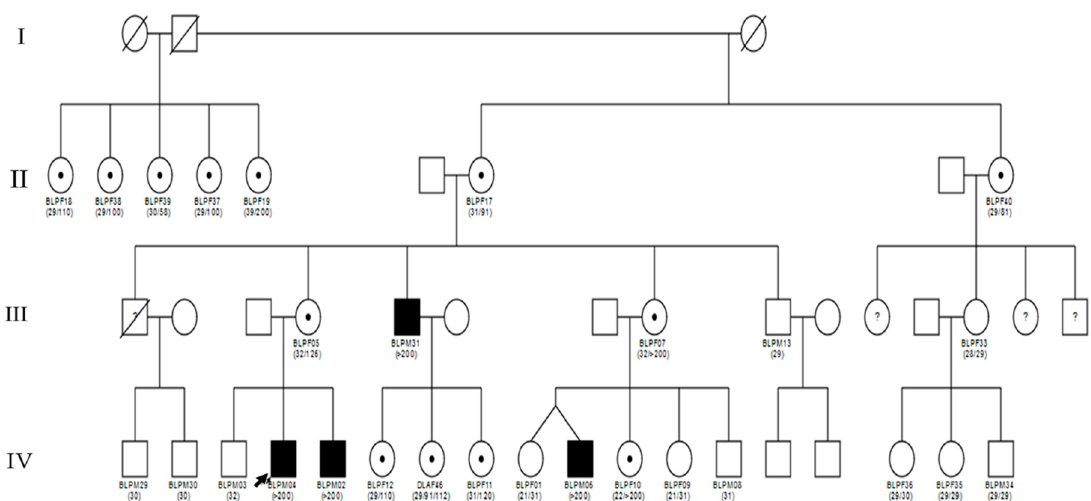
Figure 2. Description of our proband’s family. The number in brackets below the symbols as the number of CGG repeats in the FMR1 gene.